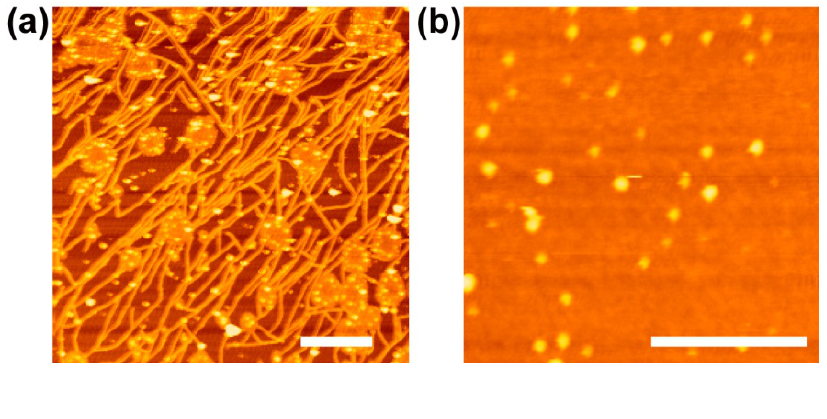
Figure 7. AFM topographies of SM + Chol + GM1-SLBs on ( a ) mica and ( b ) SiO incubation in the presence of A β of 2 µM at 37 °C for 24 h. Scale bars are 1 µm. Reprinted from [137] with modification with permission from